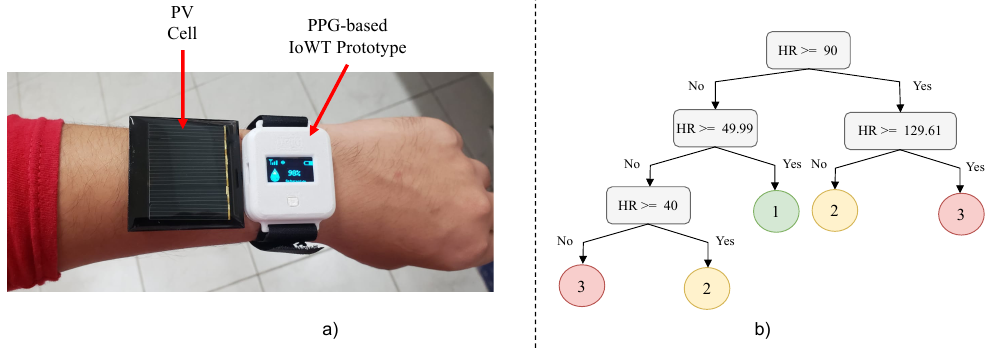
Figure 6. Experimental results: ( a ) Wearable electronic prototype with decision tree power manage- ment; and ( b ) Decision tree split result